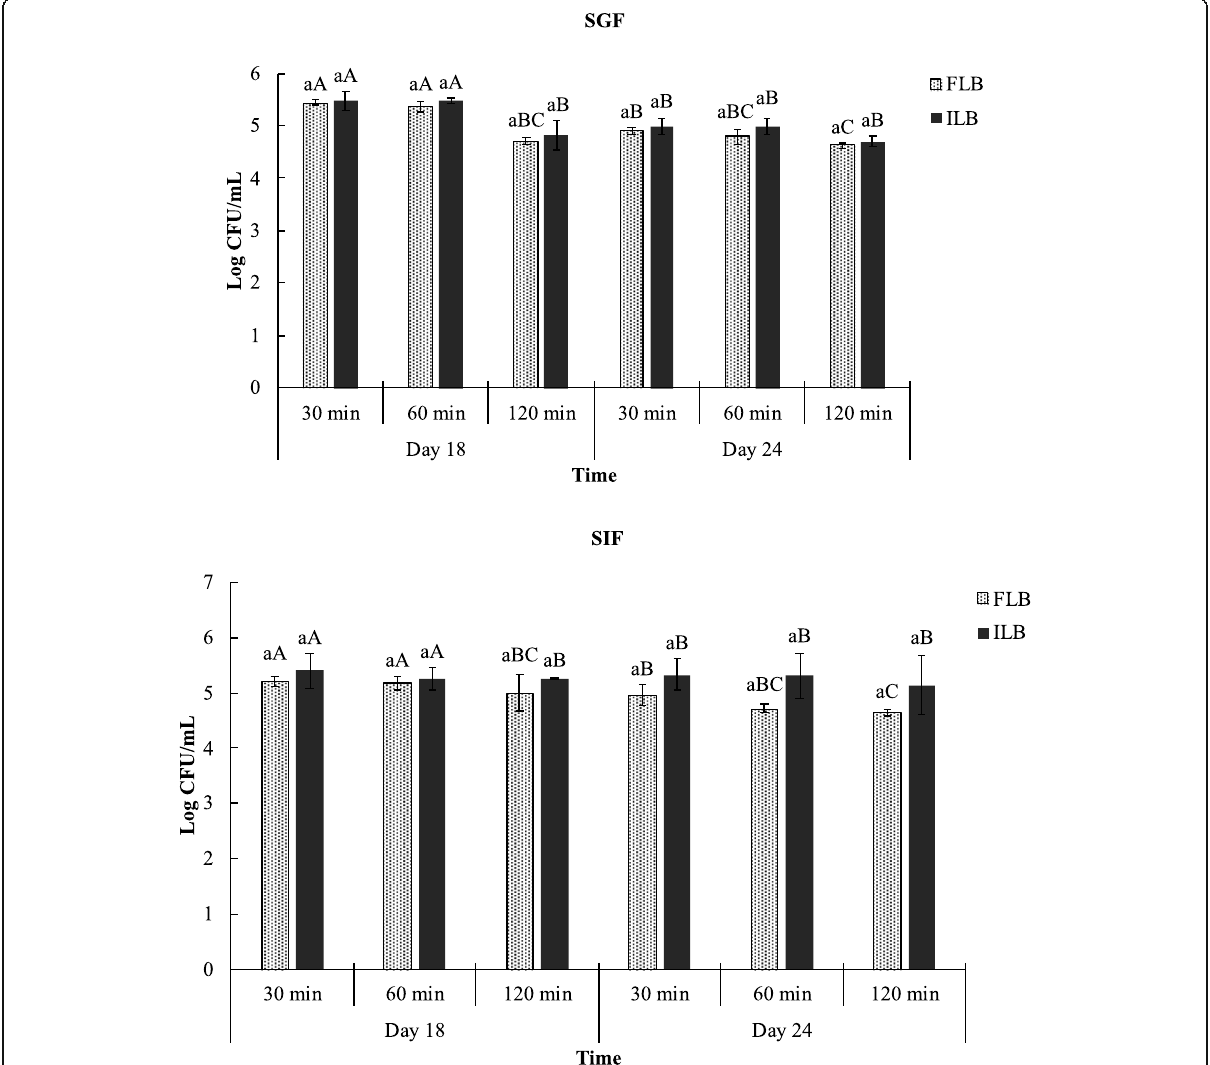
Fig. 7 Viability of FLB and ILB in ale beer during 24 days of storage at 21 °C followed by exposure to SGF (pH = 3.0) and SIF (pH = 6.5). a Means with no letter in common between treatments within the same incubation time are significantly different ( P < 0.05). A-C Means with no letter in common within the same treatment across incubation times are significantly different ( P < 0.05). FLB = free Lactobacillus brevis and ILB = immobilized Lactobacillus